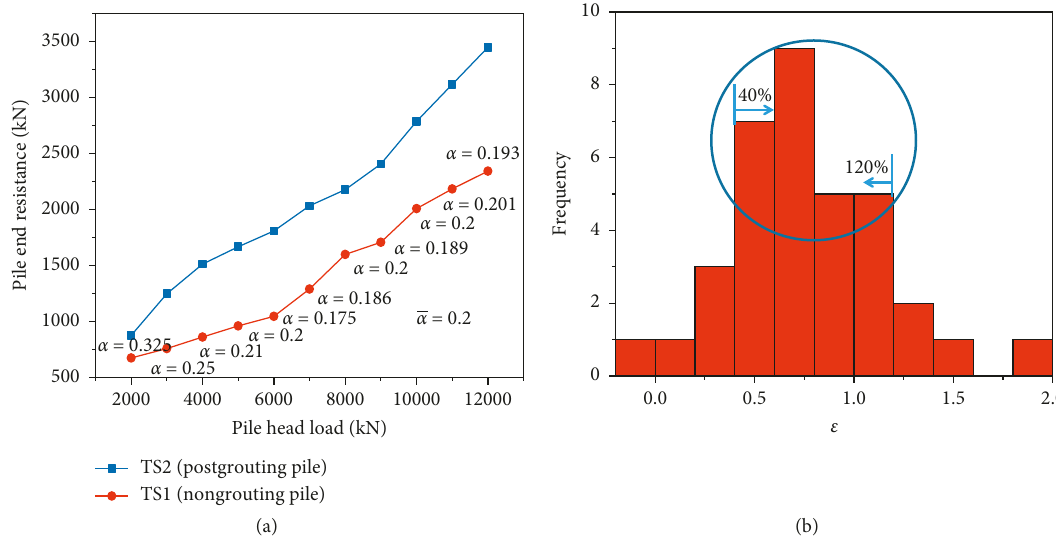
Figure 10: (a) End resistance ratio of piles TS1 and TS2 under different loads; (b) statistical chart of the end resistance ratio improvement coefficient ε after grouting.